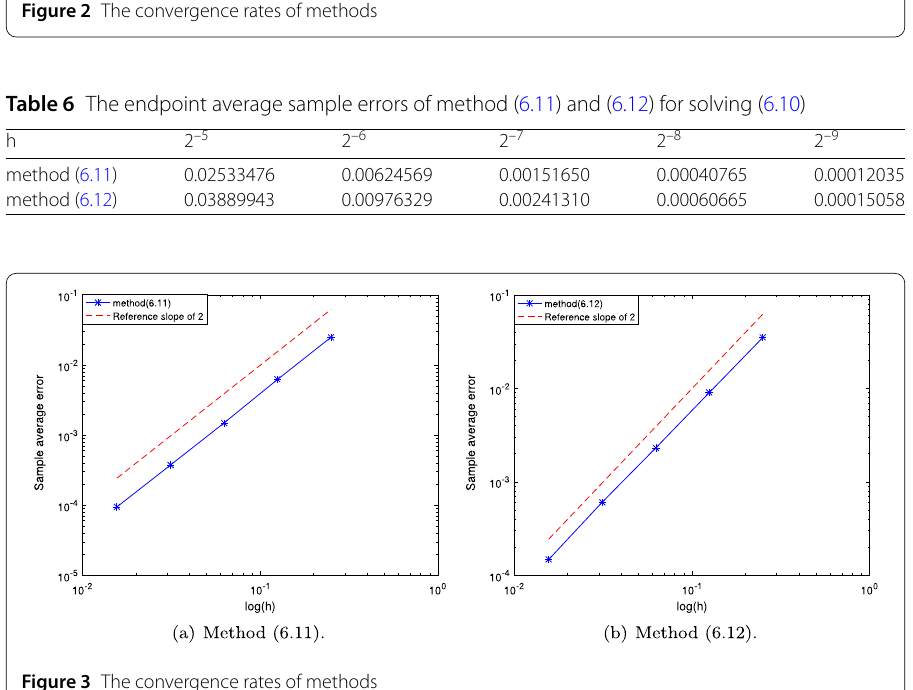
Figure 3 The convergence rates of methods